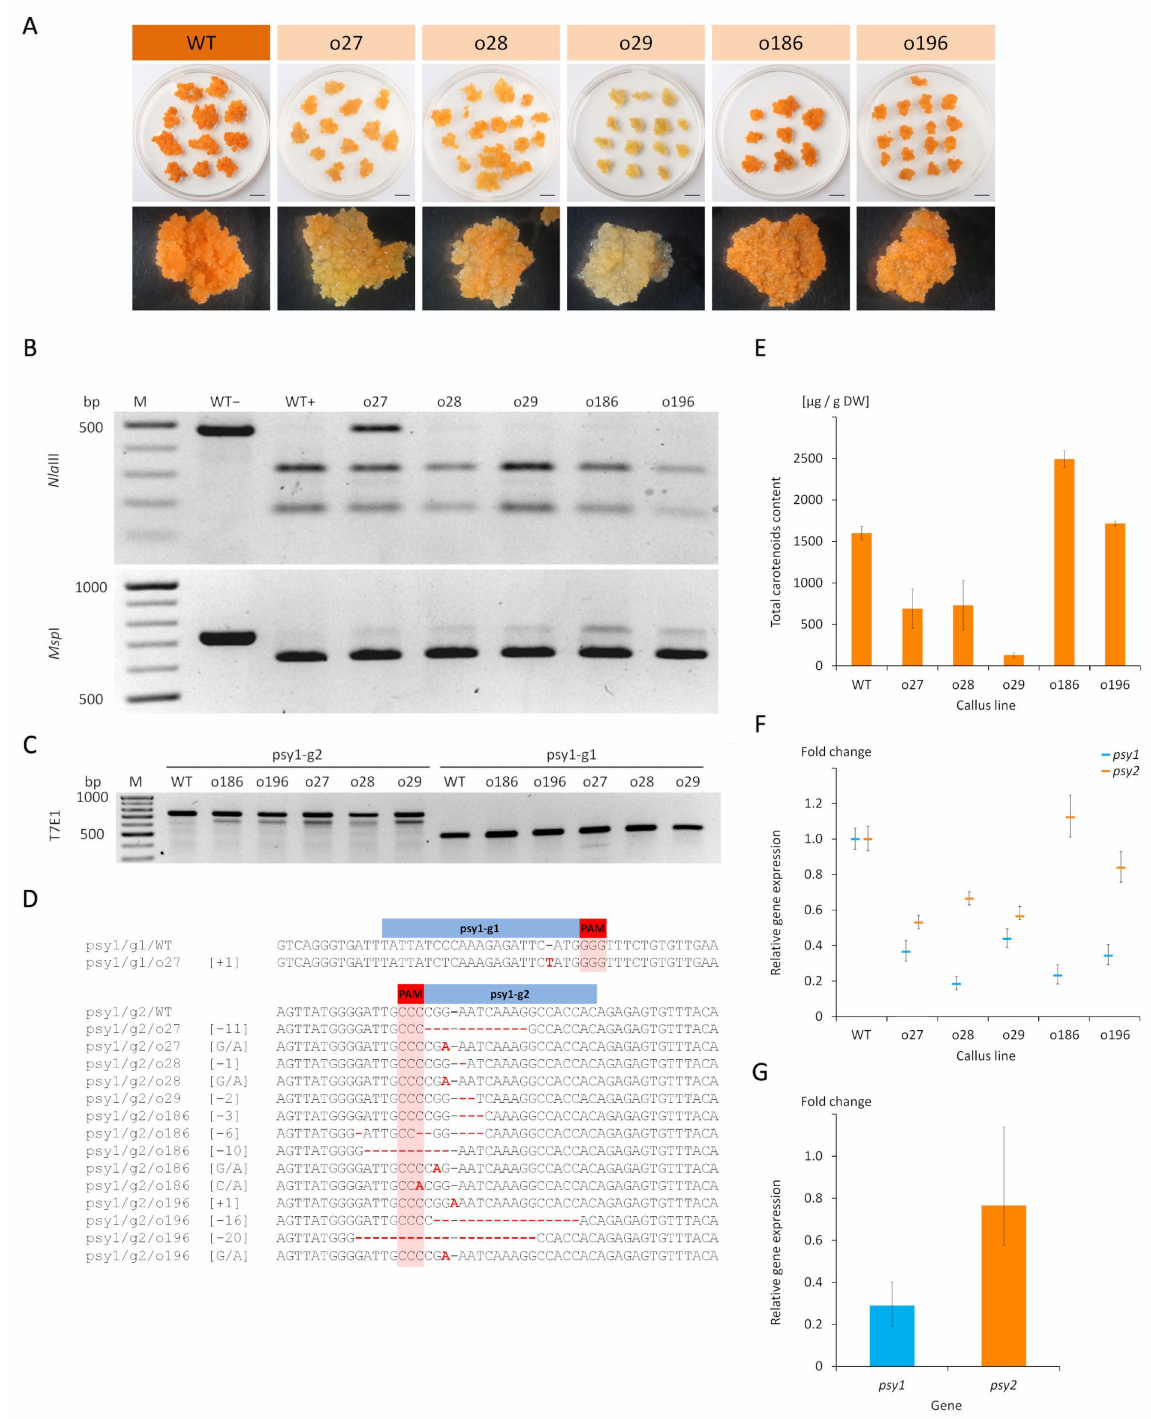
Figure 2. Carrot callus lines selected after transformation using the psy1-g1g2 vector with gRNAs targeting the psy1 gene. ( A ) Developing callus in vitro. Separation of PCR fragments after restriction with ( B ) specific endonucleases and ( C ) T7EI enzyme. ( D ) Results of Sanger sequencing of target sites in the psy1 gene. ( E ) Total carotenoid content. Relative psy1 and psy2 gene expressions in ( F ) each callus line and ( G ) the mean relative expressions. Scale bars represent 1 cm; WT–wild type callus (not transformed control) before (–) and after (+) restriction; o27-o196–transgenic callus lines; M–GeneRuler DNA Ladder Mix (Thermo Scientific, Waltham, MA, USA)